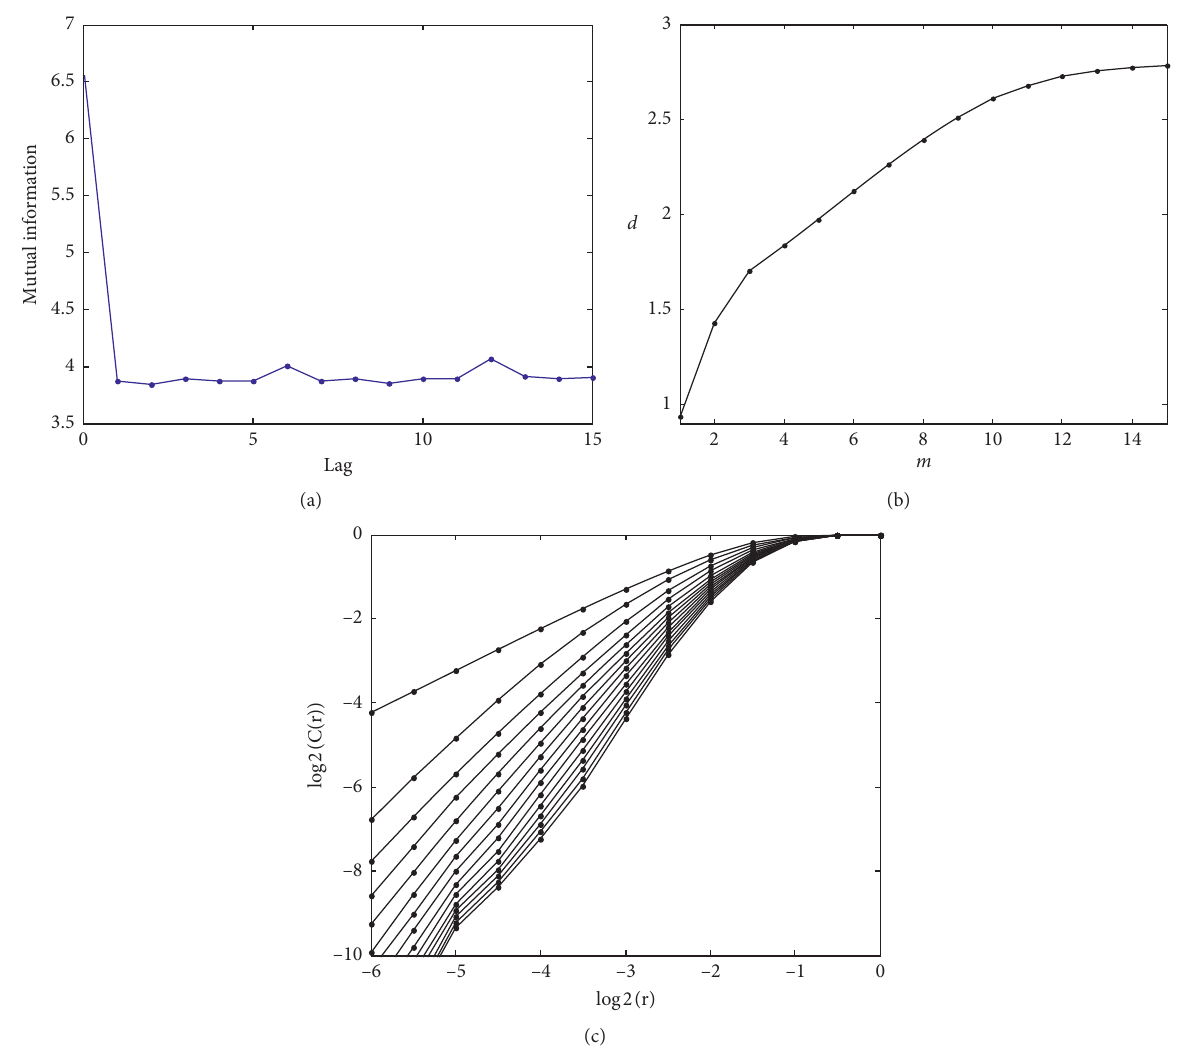
Figure 5: (a) Delay time; (b) D- m curve; (c) log